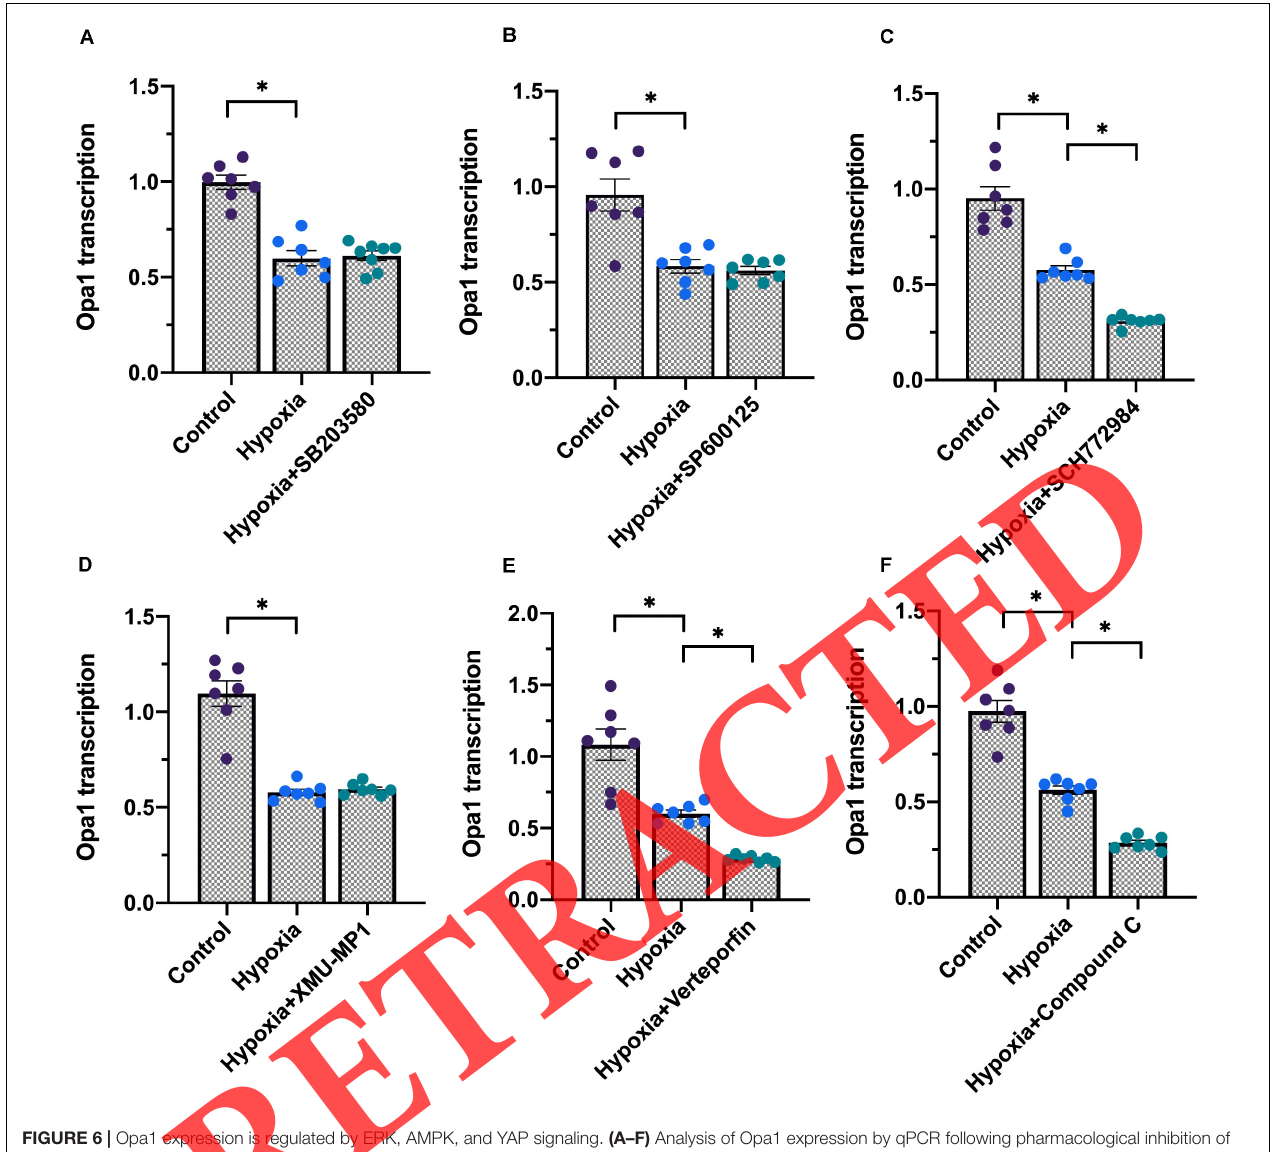
FIGURE 6 | Opa1 expression is regulated by ERK, AMPK, and YAP signaling. (A–F) Analysis of Opa1 expression by qPCR following pharmacological inhibition of MAPK/ERK, MAKPK/JNK, MAPK/p38, AMPK, Hippo/MST1, or Hippo/YAP. See “Materials and Methods” for details. ∗ p <